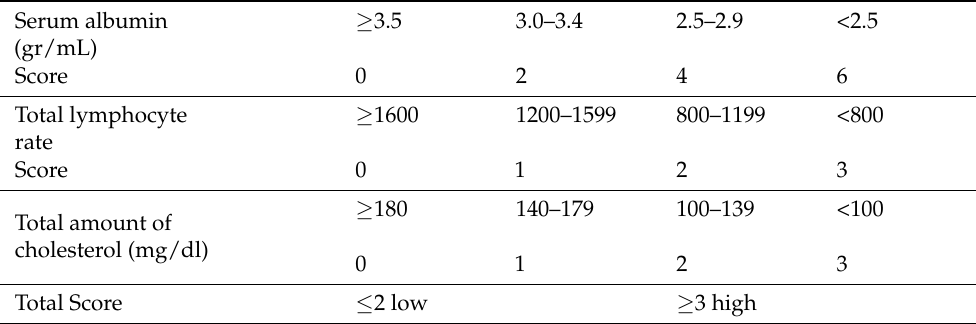
Table 1. Evaluation of nutritional status by way of Controlled Nutritional Status (CONUT) score.